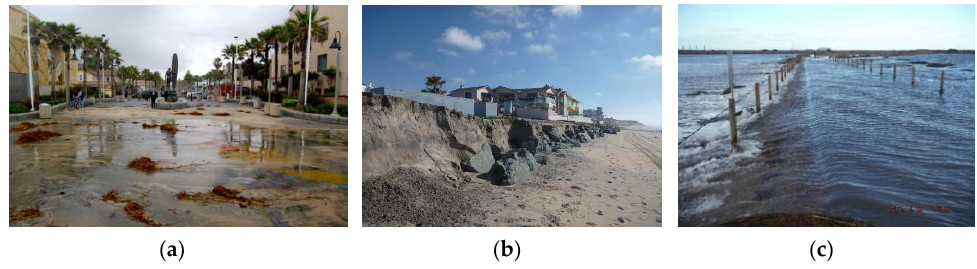
Figure 4. Coastal hazards ( a ) wave flooding, ( b ) coastal erosion, ( c ) tidal